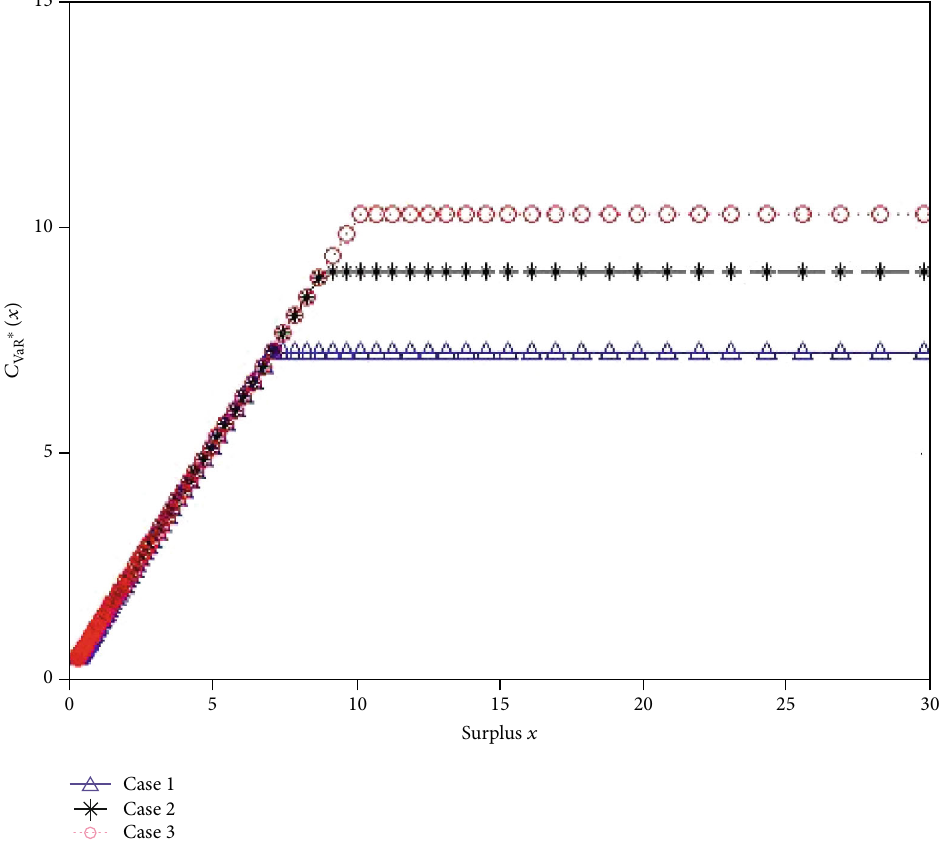
Figure 4: c ∗ ð x Þ change with x under the VaR